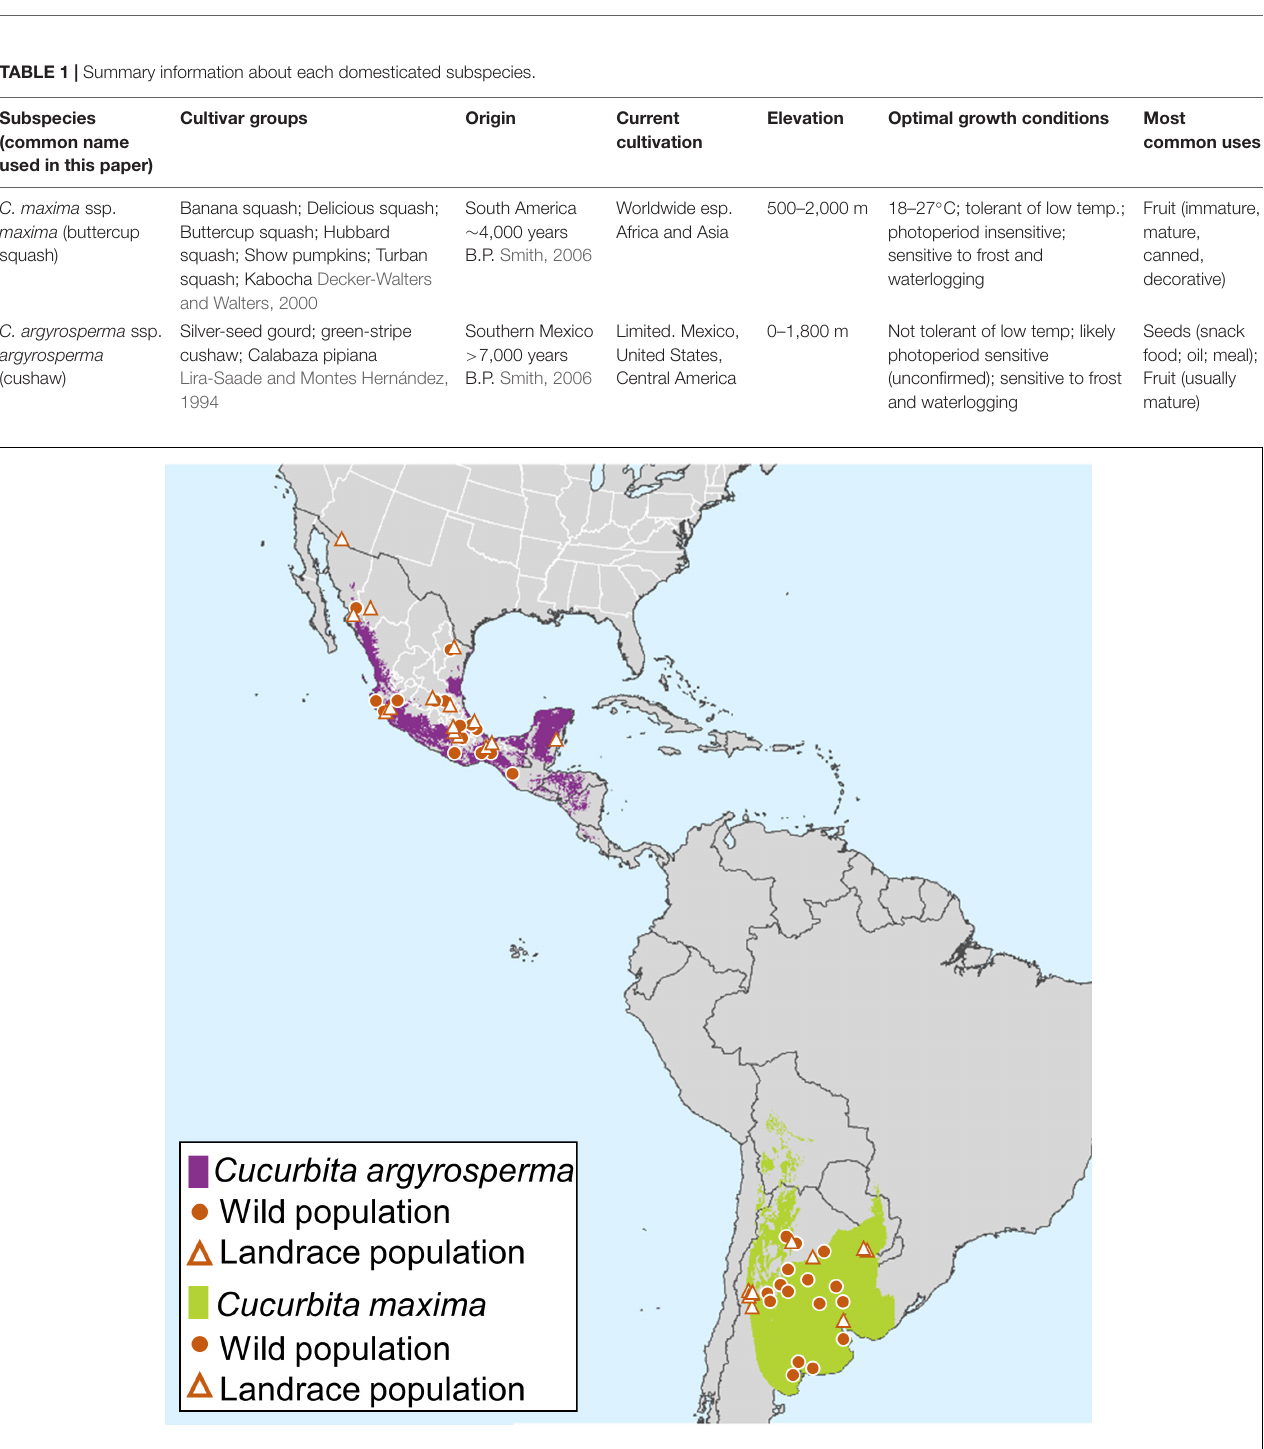
FIGURE 1 | Map of putative range of wild and landrace C. maxima and C. argyrosperma with sampling localities (if known) for landrace and wild samples included in this study. For Cucurbita argyrosperma (purple), distribution is based on 620 occurrence points from GBIF (gbif.org). For C. maxima (green), distribution is based on 58 occurrence points from GBIF (gbif.org), Specieslink (splink.cria.org.br/), Discover life (www.discoverlife.org), and CONABIO (conabio.gob.mx). Landrace samples are indicated by triangles and wild samples are indicated by solid circles.